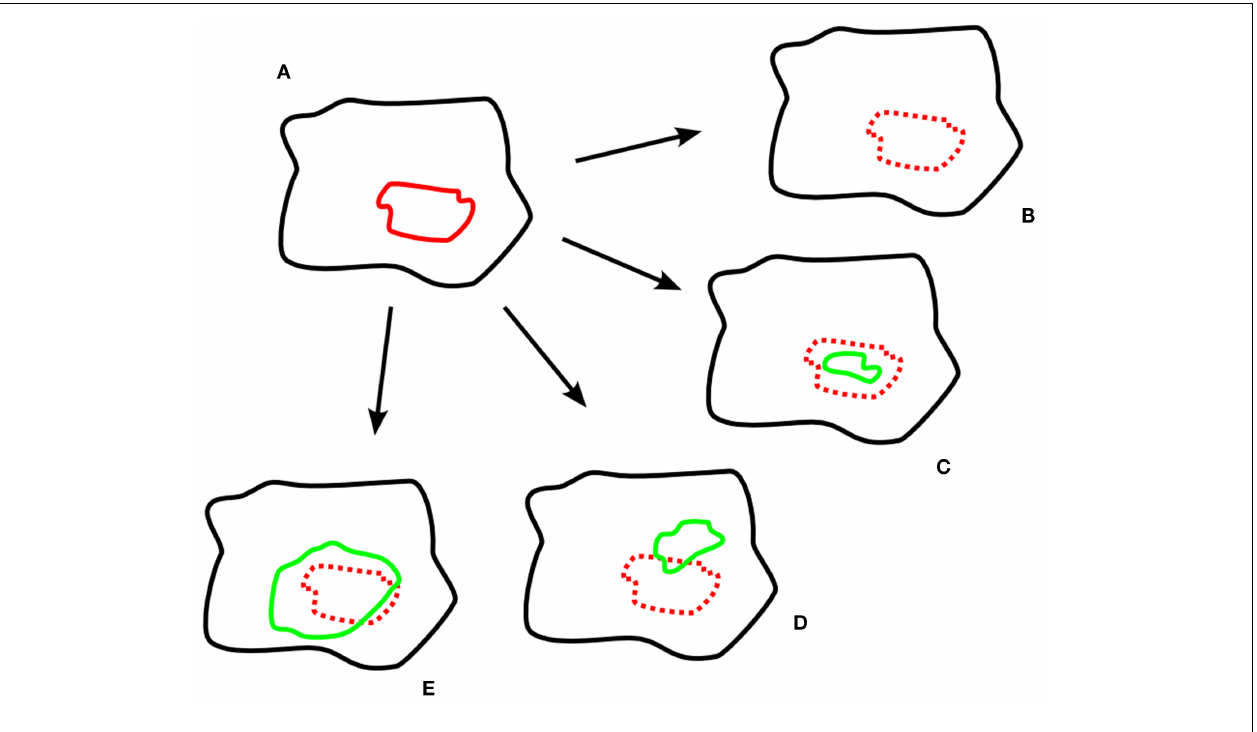
geographically unstable hypoxia; (E) increased hypoxia. Legend: black: tumor volume; red: hypoxic subvolume pre-treatment; green: hypoxic subvolume during